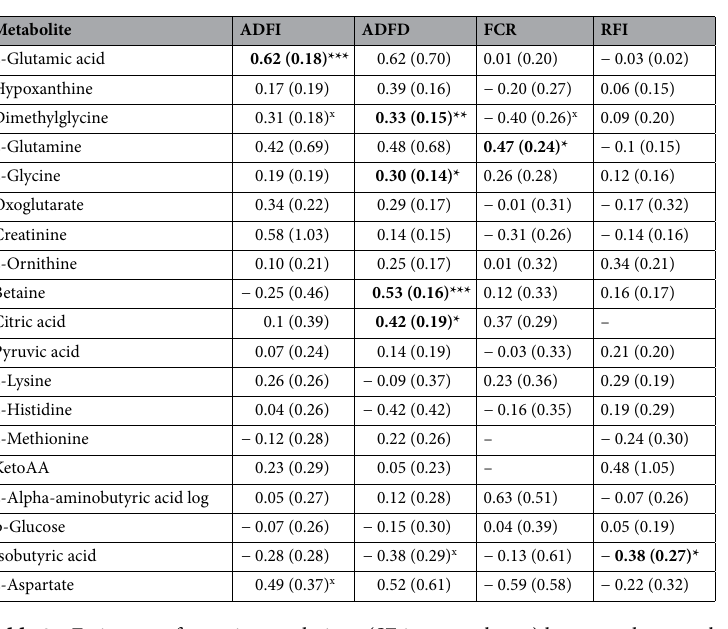
Table 3. Estimates of genetic correlations (SE in parentheses) between the most heritable metabolites and average daily feed intake (ADFI), duration (ADFD), feed conversion ratio (FCR) and residual feed intake (RFI). Significance of genetic correlations are indicated in bold as: ***, **, *, x corresponding to P < 0.001, P < 0.01, P ≤ 0.05 and 0.05 < P < 0.10 respectively. “–” indicates not estimable.